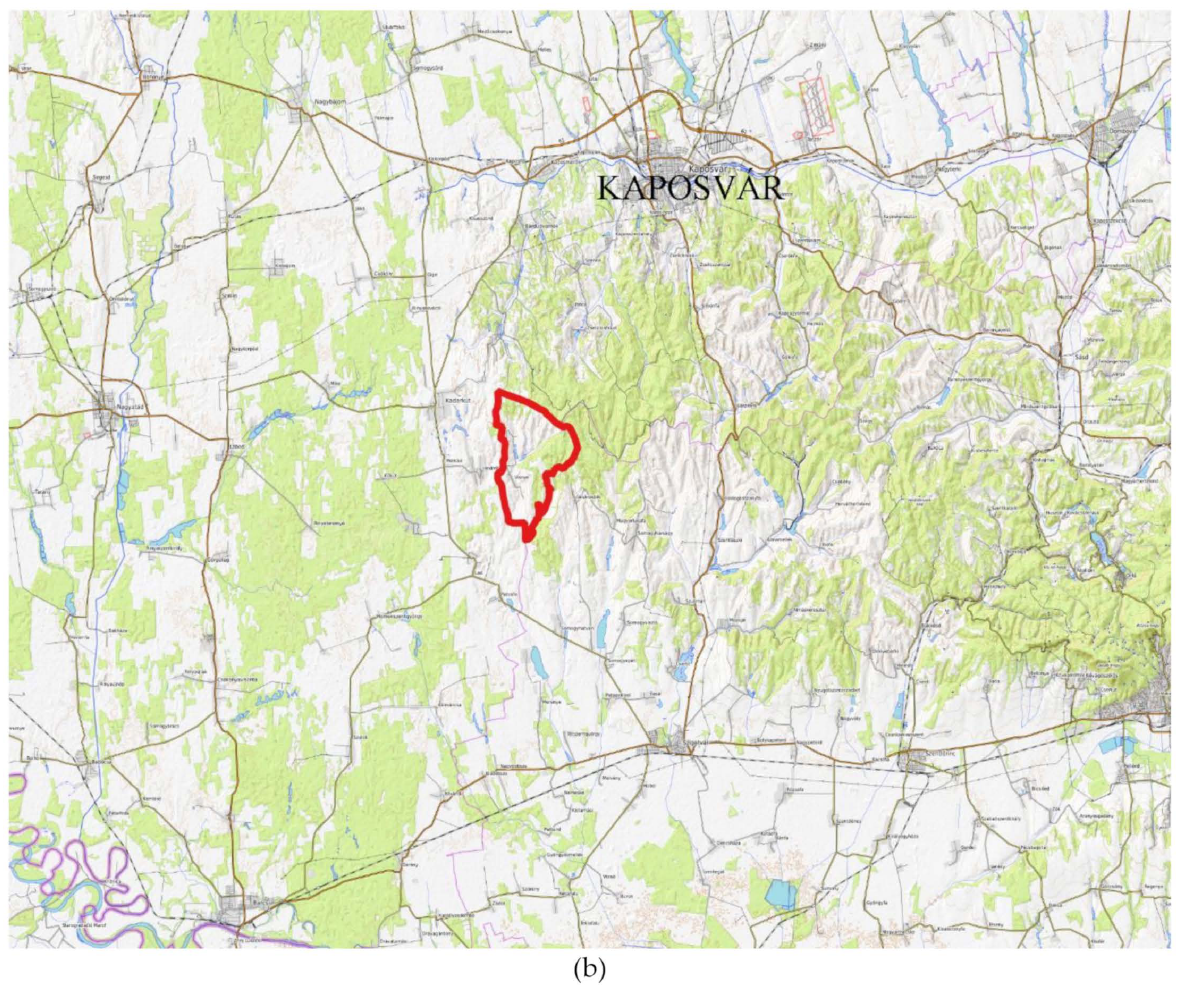
Figure 3. Overview map of Visnye in Hungary ( a ) and in regional scale ( b